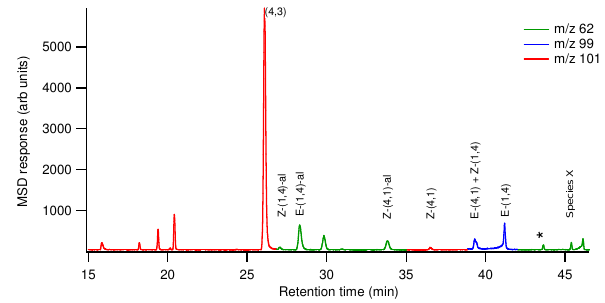
Figure 4. Composite extracted-ion chromatogram showing INs formed during a bag photochemistry experiment and analysed on a 30m, 0.32mm ID, Rtx-1701 column. The conditions for the photol- ysis are similar to those used in Fig. 3, and the analytical conditions are identical to those used for the Rtx-200 column used in Fig. 3. The E-(4,1) and Z-(1,4) isomers are not separated under the column conditions used. The peak marked ( ∗ ) is the same retention time and major ions as the impurity in the synthesised species X. MSD (mass selective detector) is the mass